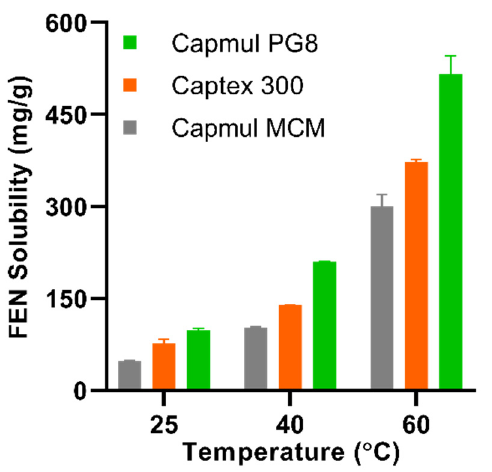
Figure 1. The temperature-dependent solubility of fenofibrate (FEN) in Capmul MCM (grey bars), Captex 300 (orange bars), and Capmul PG8 (green bars). Values represent mean ± SD, n = 3.